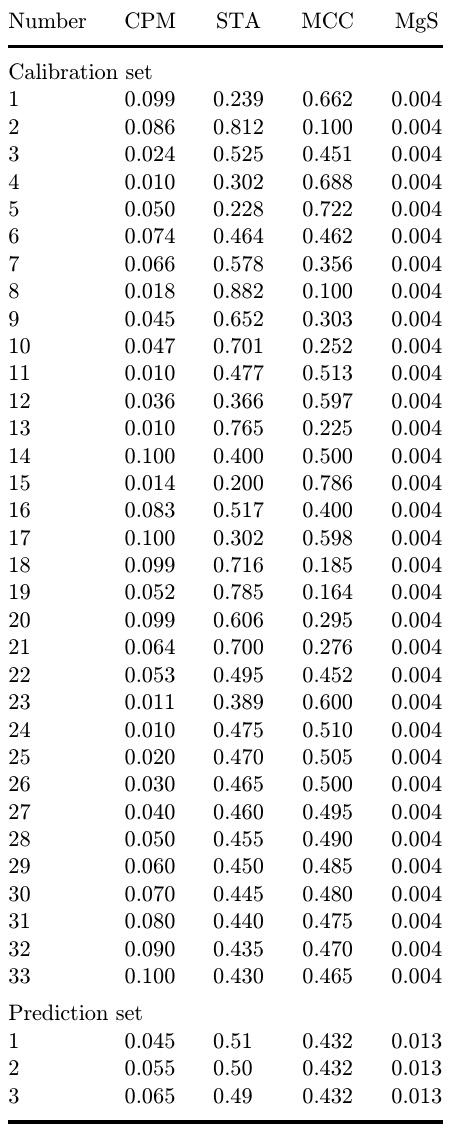
Table 1. The content of components of each batch